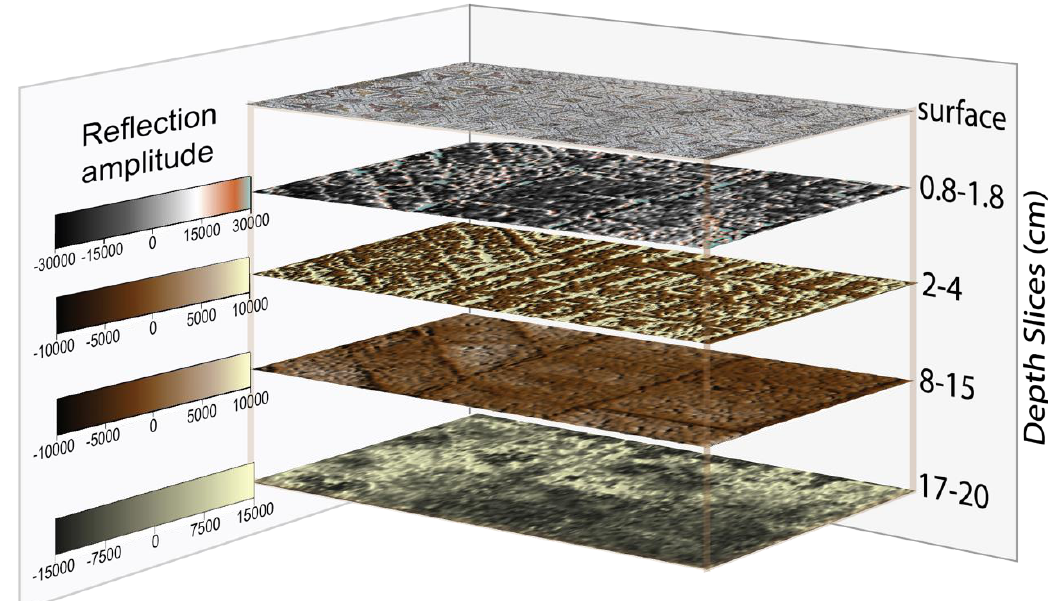
Figure 13. Summary of the most significant levels detected in the 3D-GPR survey, collected with a 1600 MHz antenna. The color scales correspond to the amplitude of the reflections.